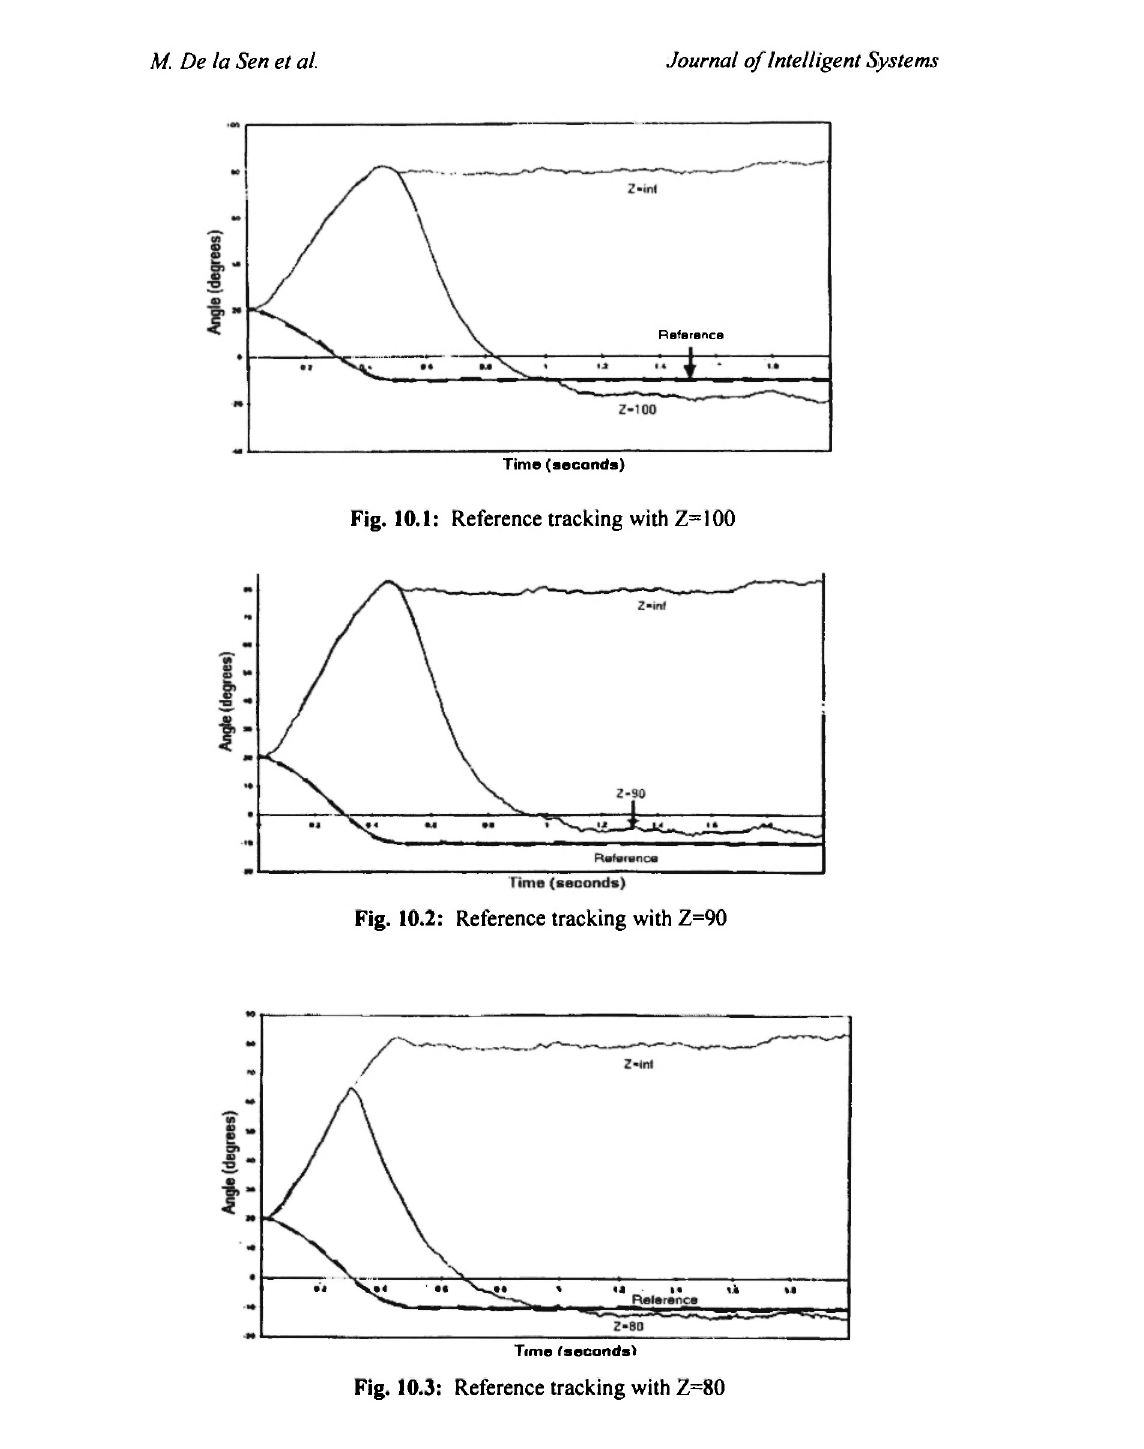
Fig. 10.3: Reference tracking with